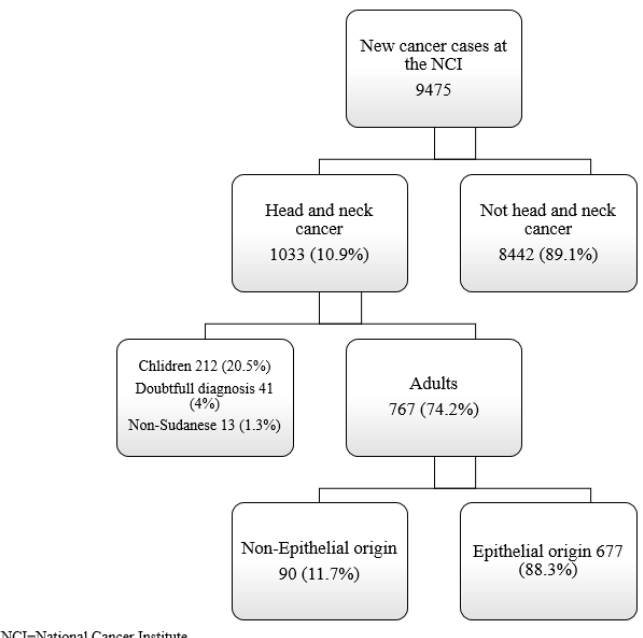
Figure 1. Flowchart of the inclusion of subjects from the study period.